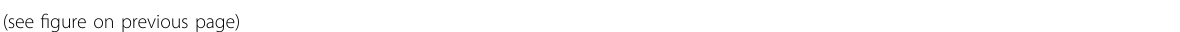
Fig. 4 Depletion of Kindlin-2 activates Hippo pathway and inhibits YAP nuclear localization. A, B Volcano plots showing differential expression in TM4 ( A ) or 15P-1 ( B ) cells transfected with Kindlin-2 siRNA or control siRNA. Genes which have greater than or equal twice-fold difference expression among two groups were shown in gray (downregulated) or orange (upregulated), P adj < 0.05. C Overlap of genes regulated by depletion of Kindlin-2 in TM4 ( A ) and 15P-1 ( B ) cells were shown in Venn diagram. Comparing transcript abundances in control cells and Kindlin-2 inhibited cells revealed 3146 and 2802 signi fi cantly altering genes in TM4 and 15P-1 cell respectively. A total of 2203 altering genes overlapped in both two cells, in which 1583 genes were down-regulated and 620 genes were up-regulated. P adj < 0.05. D KEGG enrichment of 1583 down-regulated genes after Kindlin-2 depletion. KEGG analysis was carried out by using DAVID online tool. Enrichment scores were shown as − log10 ( P -value). E A heat map analysis of Hippo signaling pathway related genes. Blue and red square frames represent low or high expression levels respectively. F Control and Kindlin-2 siRNAs were transiently transfected into TM4 and 15P-1 cells separately, after 48 h, qPCR was performed to detect the expression of cell junction related genes ( Jam2 and Dlg2 ) and Hippo signaling genes ( Wnt4, Wnt10b, TGF β 2 and Cypr61 ) using speci fi c primers. GAPDH was used as internal reference. Three independent experiments were involved. Data are mean ± s.e.m. The variance was similar between the groups. * p < 0.05, ** p < 0.01 and *** p < 0.001 by Student ’ s t -test. G Representative Western blot analyses of Hippo signaling pathway factors pMST1, MST1, pMOB1, MOB1, pLATS1-909, LATS1, pYAP-127 and YAP using speci fi c antibodies through loss of function of Kindlin-2 in two cell lines TM4 and 15P-1. β -actin acts as an internal reference. H Left: Representative immunohistochemistry detection for YAP in 4 W WT and KO mice testis. The red arrows show SCs nucleus and the black arrows showed the nucleuses of spermatogenic cells. Scale bar, 50 μ m. Magni fi cations were shown on the right panel; red arrows indicate the staining of YAP in Sertoli cells. Right: quantitative analysis to compare the amount of Yap in spermatogenic nuclei and Sertoli nuclei of KO testes to WT testes. The variance was similar between the groups. *** p < 0.001 by Student ’ s t -test. I Nuclear and cytoplasmic proteins isolated from TM4 and 15P-1 cells transfected with control or Kindlin-2 siRNAs were subjected to immunoblot analysis using antibodies against Kindlin-2, YAP and pYAP (S127). LamB1 and GAPDH were used as loading controls for nucleus and cytoplasm respectively. J Quanti fi cations of nuclear YAP of two Sertoli cell lines upon Kindlin-2 silencing or not. K Confocal images of Kindlin-2 (purple), YAP (green), CTGF (red) and DAPI (blue) immuno fl uorescence staining of 15P-1 Ctrl si cells and 15P-1 Kindlin-2 si cells (transient transfection). Scale bar, 50